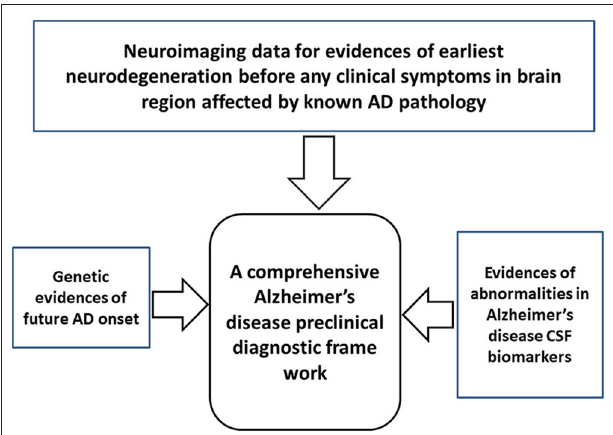
FIGURE 2 | A simple framework for comprehensive diagnosis preclinical Alzheimer’s disease (AD). The framework includes three diagnostic modalities: neuroimaging to detect the earliest evidence of neurodegeneration in brain areas susceptible to AD pathology, genetic markers associated with an AD, and biomarker testing to detect abnormalities associated with an